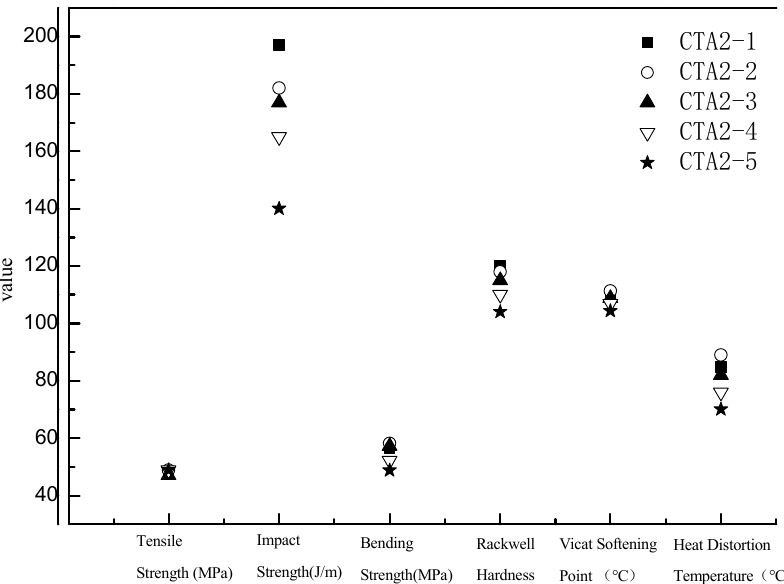
Figure 5. Influence of α -methyl styrene content on ABS resin performance.